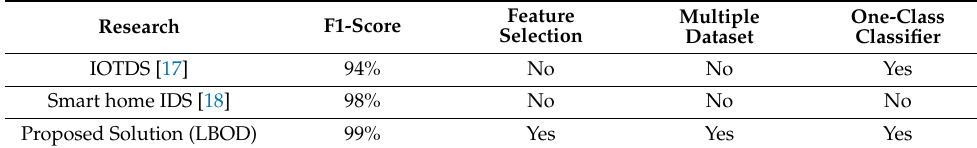
Table 5. Comparison with current research